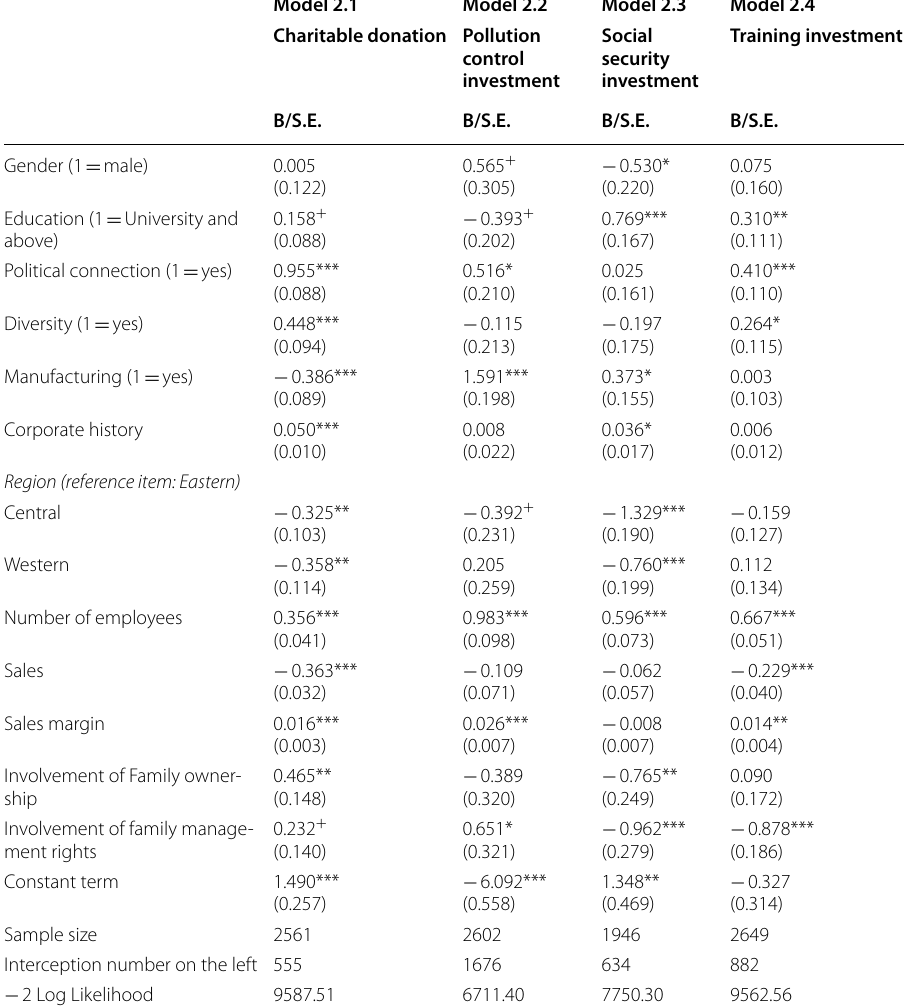
Table 3 The biggest likelihood estimate of family involvement and intensity of CSR